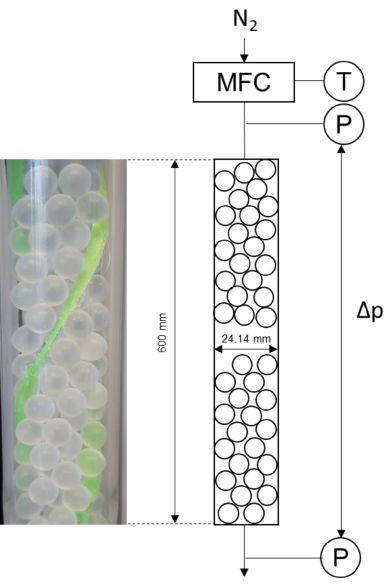
Figure 5. Experimental setup of the pressure drop measurements: details of the bed structure with 3D printed heat fins ( left ) and sketch of the experimental setup ( right